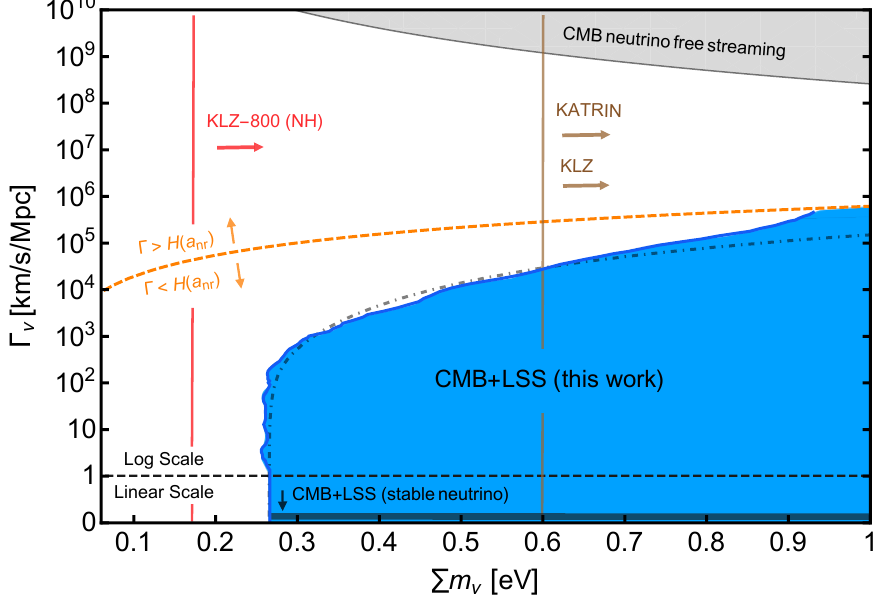
Figure 1 . The plot shows the current constraints in the m (cid:23) (cid:0) (cid:0) (cid:23) parameter space. The colored regions are excluded by current data while the white region is allowed. The orange dashed line P separates the region of parameter space in which neutrinos decay while still relativistic from that in which they decay after becoming non-relativistic. Our study focuses on the region below this line, corresponding to the latter scenario. The light grey regions show current constraints on neutrino mass and lifetime coming from CMB free streaming and the bound on stable neutrinos (labelled \CMB+LSS (stable neutrino)"). Our analysis excludes the blue region labelled \CMB+LSS (this work)" based on CMB and LSS data (Planck+BAO+Pantheon+LSS). The dash-dotted line repre- sents the approximate constraint obtained by simply requiring that the matter power spectrum be consistent with observations in the neighborhood of k = 0 : 1 h /Mpc with (cid:12)xed H 0 . This is seen to provide a reasonable estimate to the constraints from all data. The vertical brown band shows the projected KATRIN sensitivity and also the current KLZ sensitivity. The vertical red line shows the projected KLZ-800 sensitivity in the case of a normal